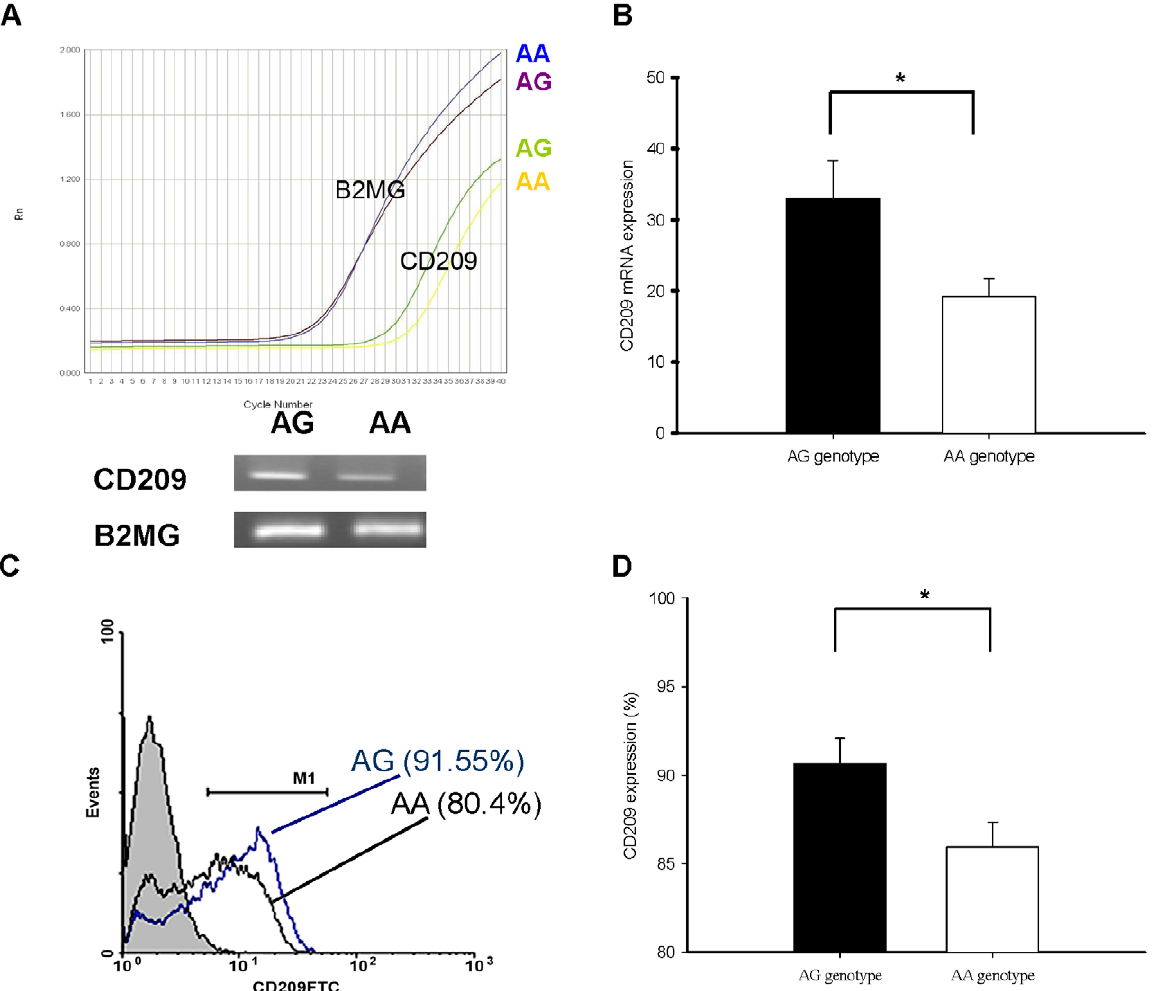
Figure 1. CD209 mRNA and cell surface expression on MDDCs with AA or AG genotype of rs4804803. (A) Quantitative RT-PCR analysis of CD209 mRNA in MDDCs was run parallel to ß2-microglobulin ( B2MG ) mRNA expression (control) on the real-time RT-PCR tracing and the gel view of RT-PCR products. (B) Subjects with rs4804803 AG genotype had higher CD209 mRNA expression in MDDCs than those with AA genotype ( p =0.032). (C) Flow cytometric analysis of CD209 surface expression on MDDCs from individuals with the rs4804803 AG genotype (blue line; MFI=34.1) and with the AA genotype (black line; MFI=30.4). (D) MDDCs from individuals with AG genotype had significantly higher CD209 cell surface expression than those with AA genotype ( p =0.029). The results are shown as mean 6 s.e.m. from subjects with AA (n=10) or AG (n=10) genotype in three independent experiments. Statistical values were determined by Mann-Whitney U test. Asterisk (*) indicates a significant difference ( p , 0.05).